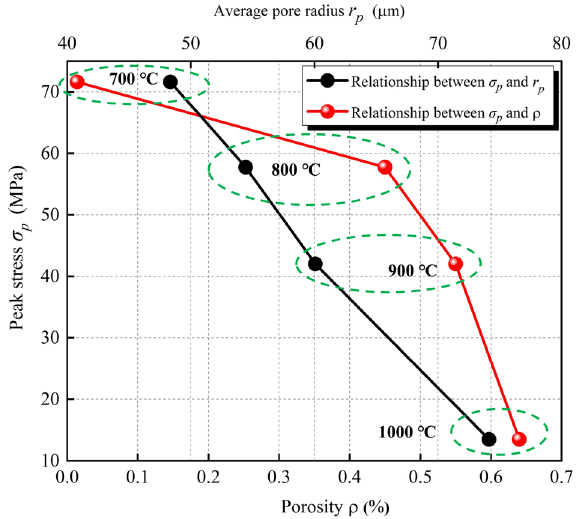
Figure 14. Relationship between porosity, average pore radius and peak stress of limestone samples after high- temperature